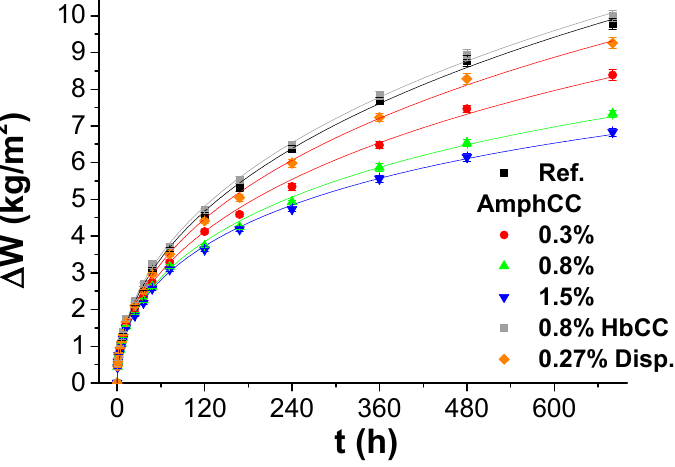
Figure 5. Water absorption of hardened mortar samples with AmphCC addition.